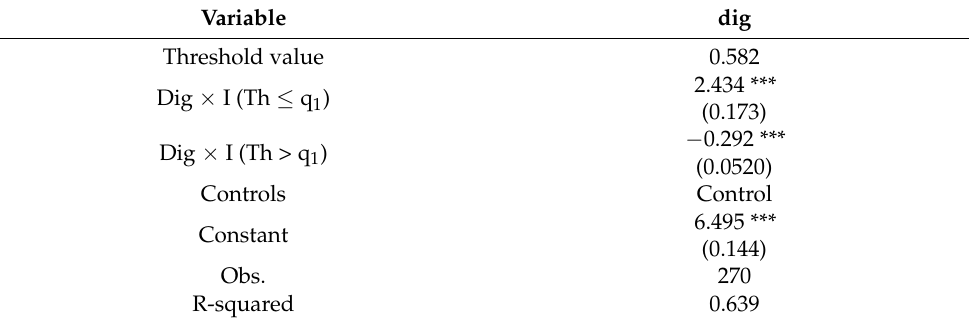
Table 5. Threshold model regression results.